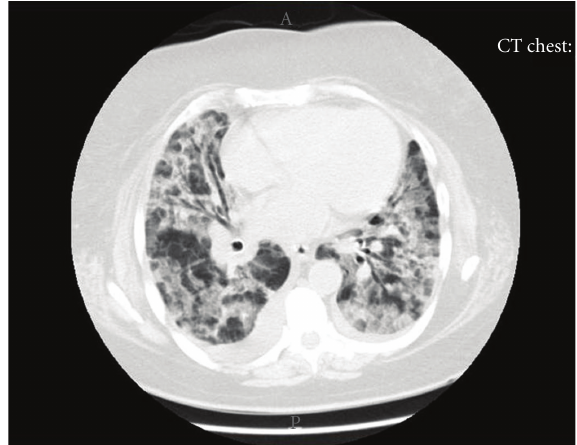
Figure 2: High resolution CT of the chest showed di ff use ground glass opacities mainly involving the upper lobes.